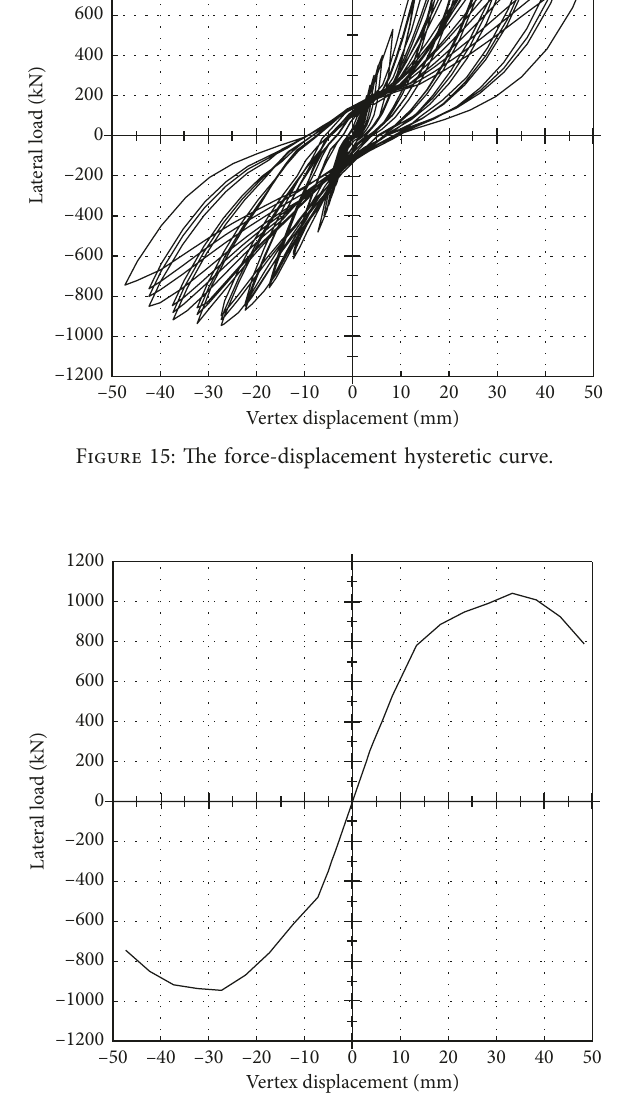
Figure 16: The force-displacement skeleton curve.